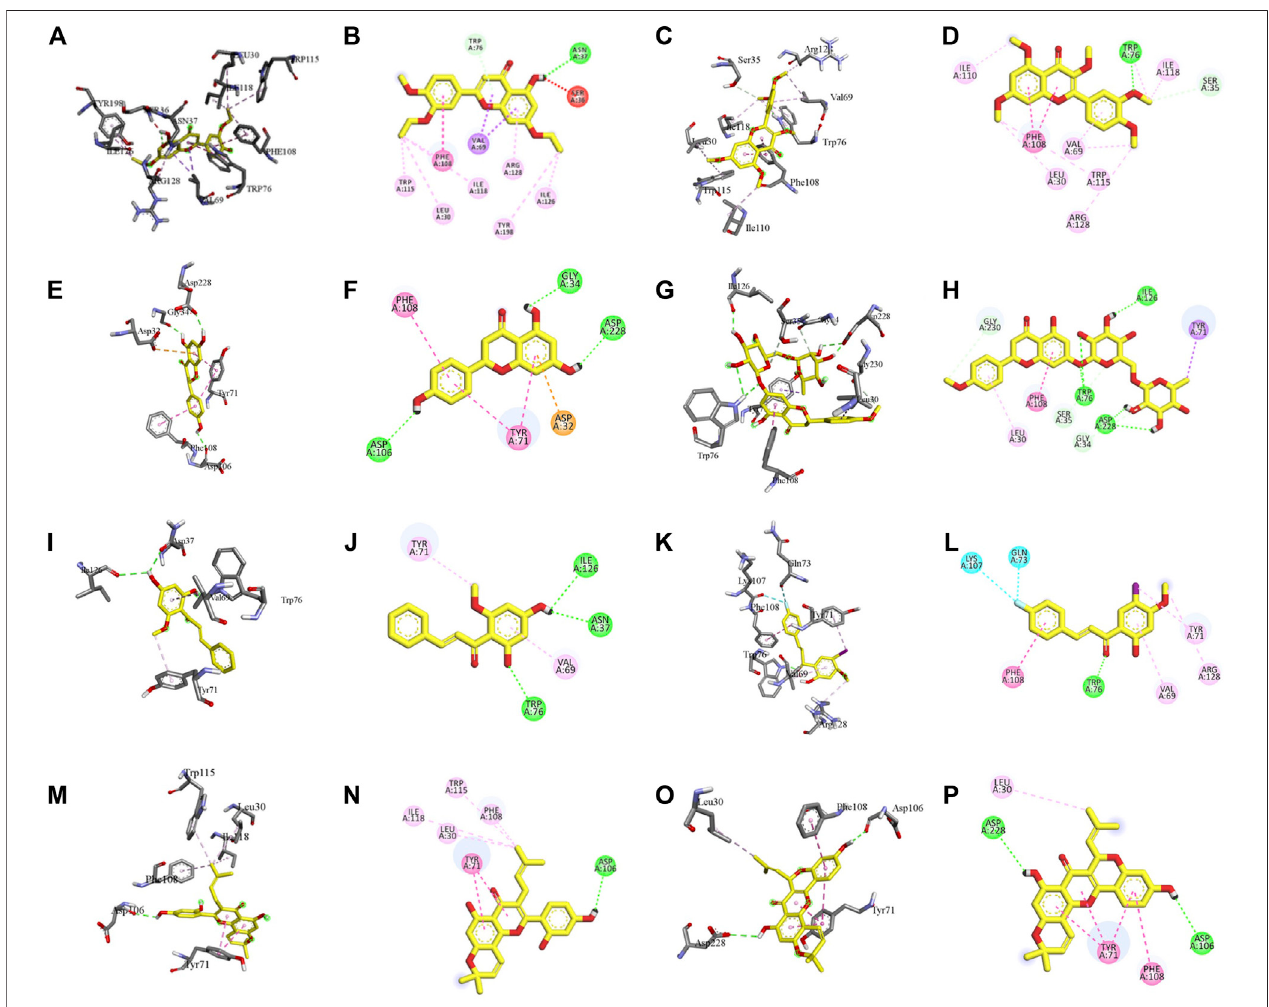
FIGURE 4 | Visualization of the protein – ligand interaction between 11 fl avonoids, which represents the 11 clusters against BACE1 from molecular docking. The fl avonoids were D3 (3 ′ ,7-diethoxy-5-hydroxy-4 ′ -methoxy fl avone (A,B) , 3,5,7,3 ′ ,4 ′ -pentamethoxy fl avone (C,D) , naringenin (E,F) , didymin (G,H) , cardomin (I,J) , 2n (K,L) , morusin (M,N) , cyclomorusin (O,P) , morusinol (Q,R) , neocyclomorusin (S,T) , biochanin A (U,V) , and PC4 (4 ′ -piperazinoacetophenone-CH 3 ; (W,X) reference ligand: 2,2,4-trihydroxychalcone (Y,Z)